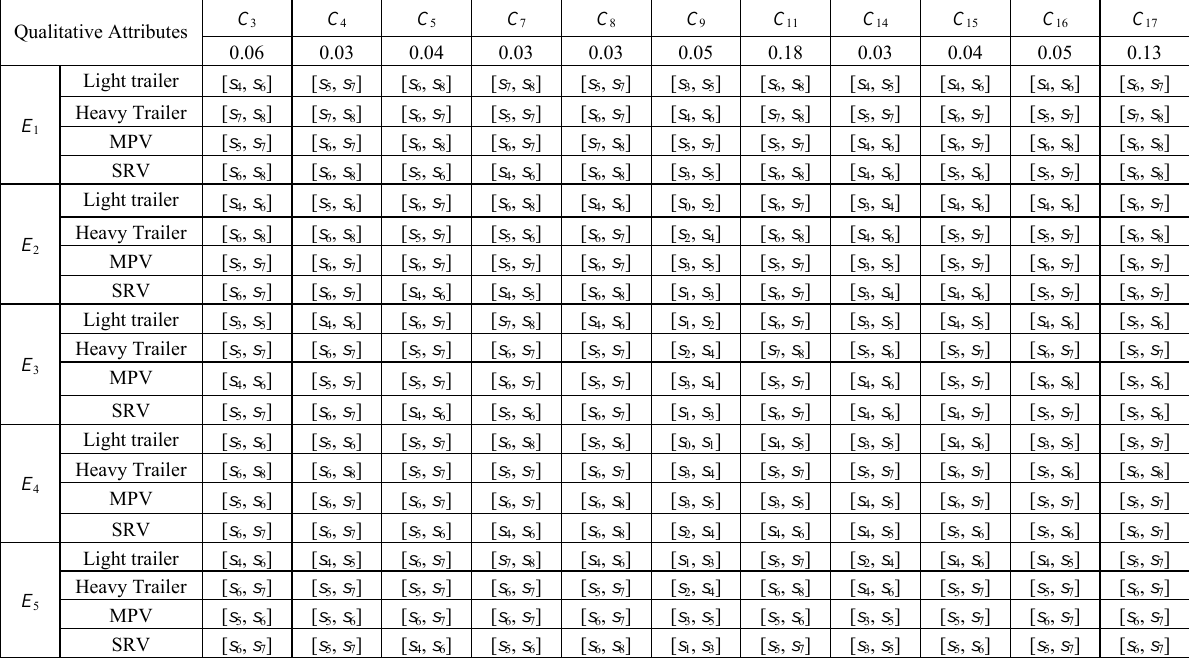
Table 3. Original evaluation of strategic R&D projects on qualitative